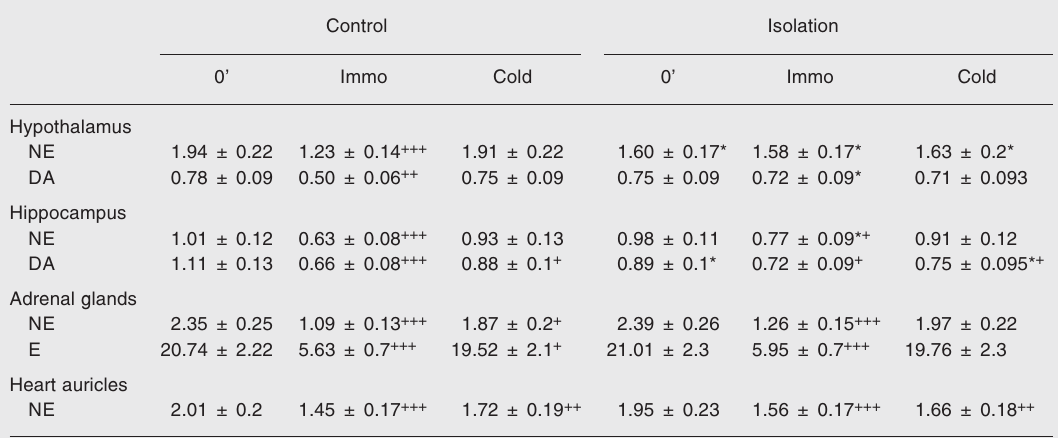
Catecholamine stores were measured by the single isotope radioenzymatic method of Peuler and Johnson (15). The means and SEM for each of the two central and two peripheral tissues were calculated for each group of 6 animals. Social isolation was compared with naive control. Immobilization and cold stress were compared with their zero point. NE = norepinephrine; E = epinephrine; DA = dopamine; Immo = immobilization; cold stress = 0' to 2 h. *P < 0.05 for 21-day social isolation vs naive control (two-way factorial ANOVA). + P < 0.05; ++ P < 0.01; +++ P < 0.001 for immobilization and cold stress compared to their zero point (two-way factorial